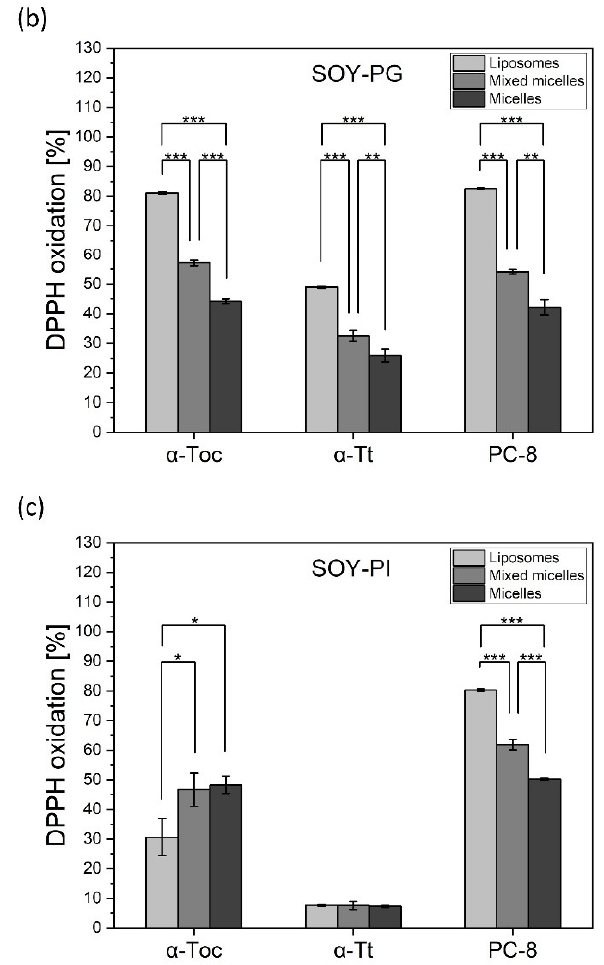
Figure 7. DPPH radical scavenging activity of α -Toc, α -Tt, and PC-8 incorporated into different nanocarriers: liposomes, mixed micelles, and micelles prepared from different soy lipids: ( a ) phos- phatidylcholine (lecithin; PC), ( b ) phosphatidylglycerol (PG), and ( c ) phosphatidylinositol (PI) The data are means ± SEM ( n = 3). Asterisks indicate statistically significant differences (* p < 0.05, ** p < 0.01, *** p < 0.001; one-way ANOVA followed by Tukey’s post hoc test).